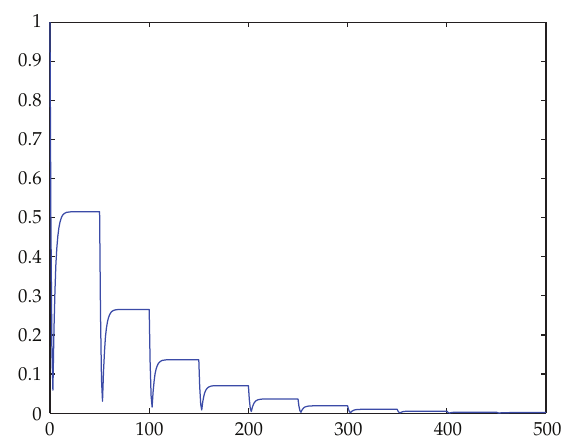
Figure 1: The Gauss collocation method with m (cid:4) 2 and p (cid:4) 50 for (cid:2) 7.1 (cid:3) .